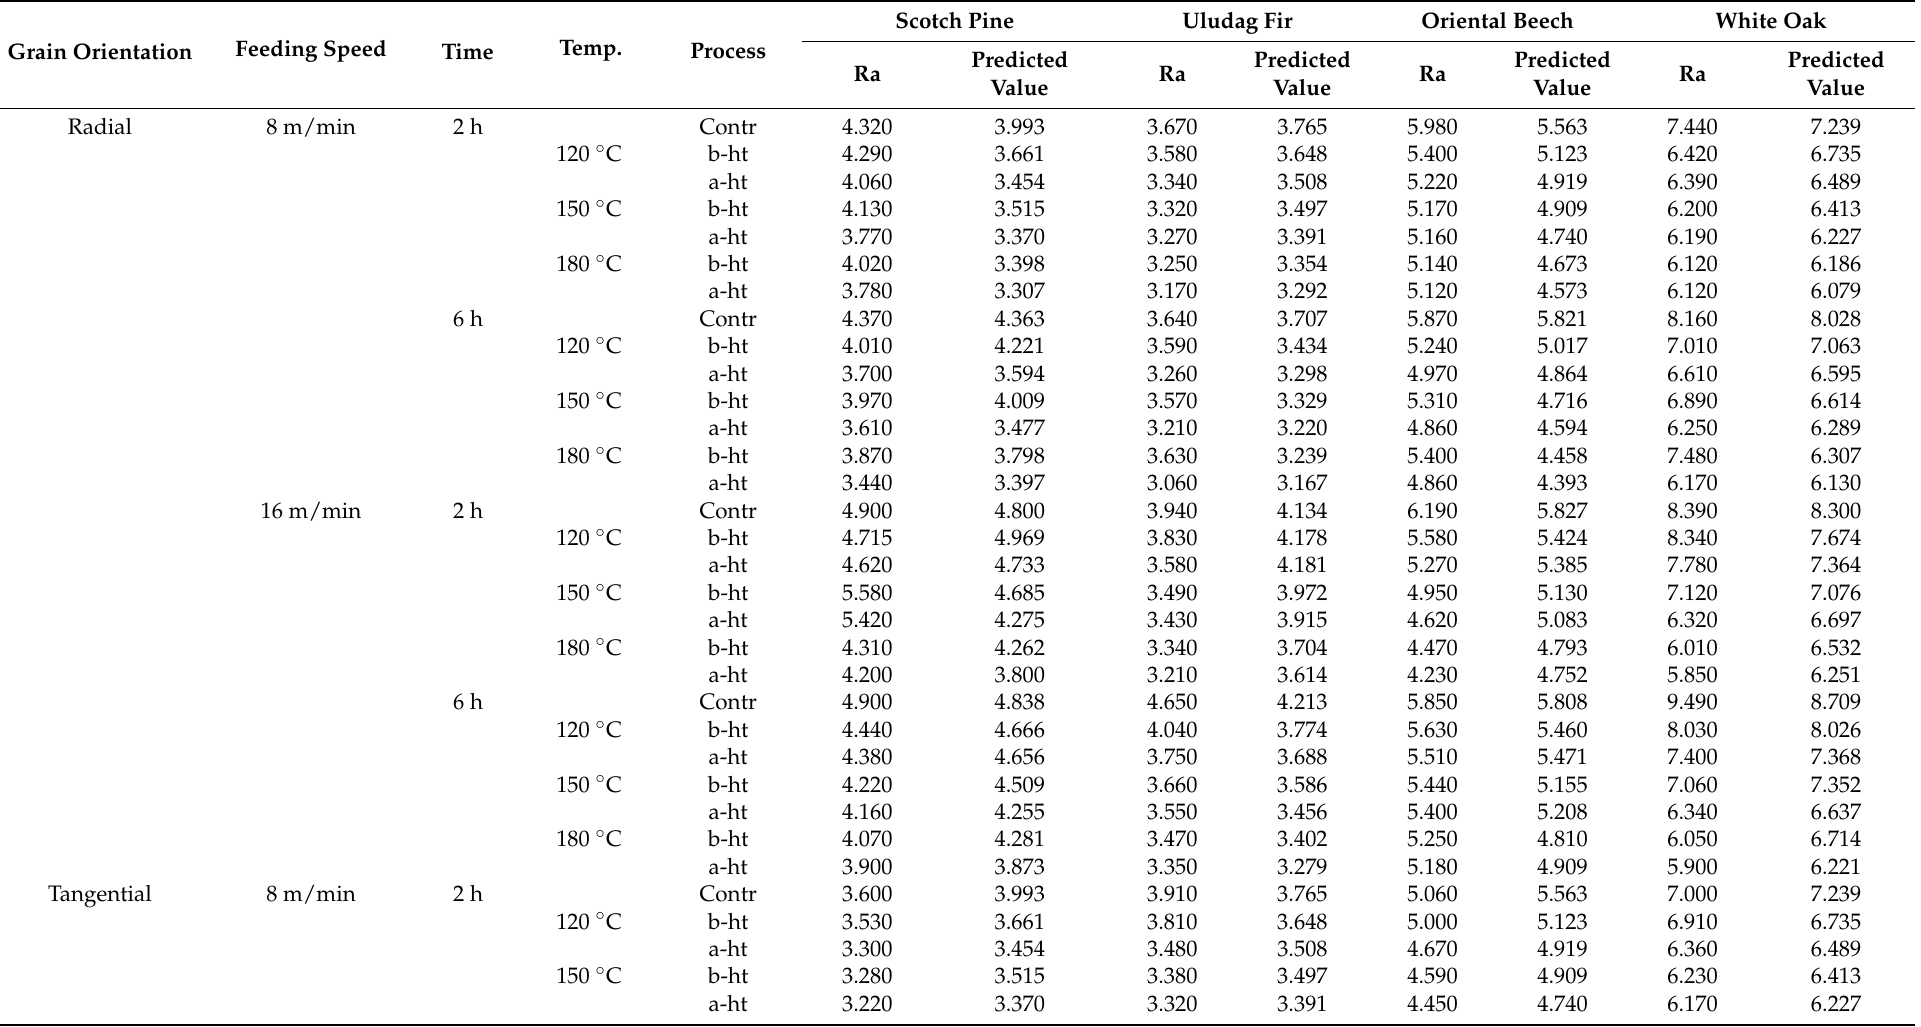
Table 6. The measured and the predicted values of surface roughness